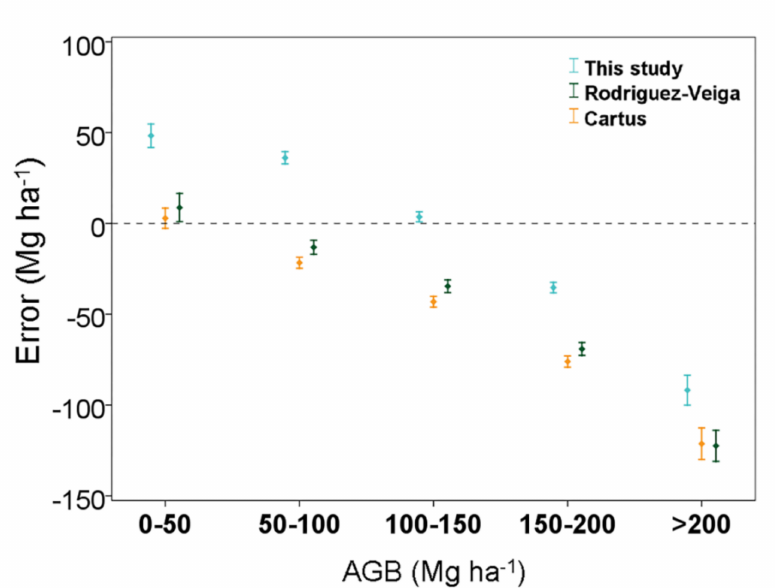
Figure 7. Mean values and 95% confidence intervals obtained as the differences between NFI field data plots used for validation and predicted AGB values of this study, and those of Cartus et al. [14] and Rodriguez-Veiga et al. [15] for different categorical AGB